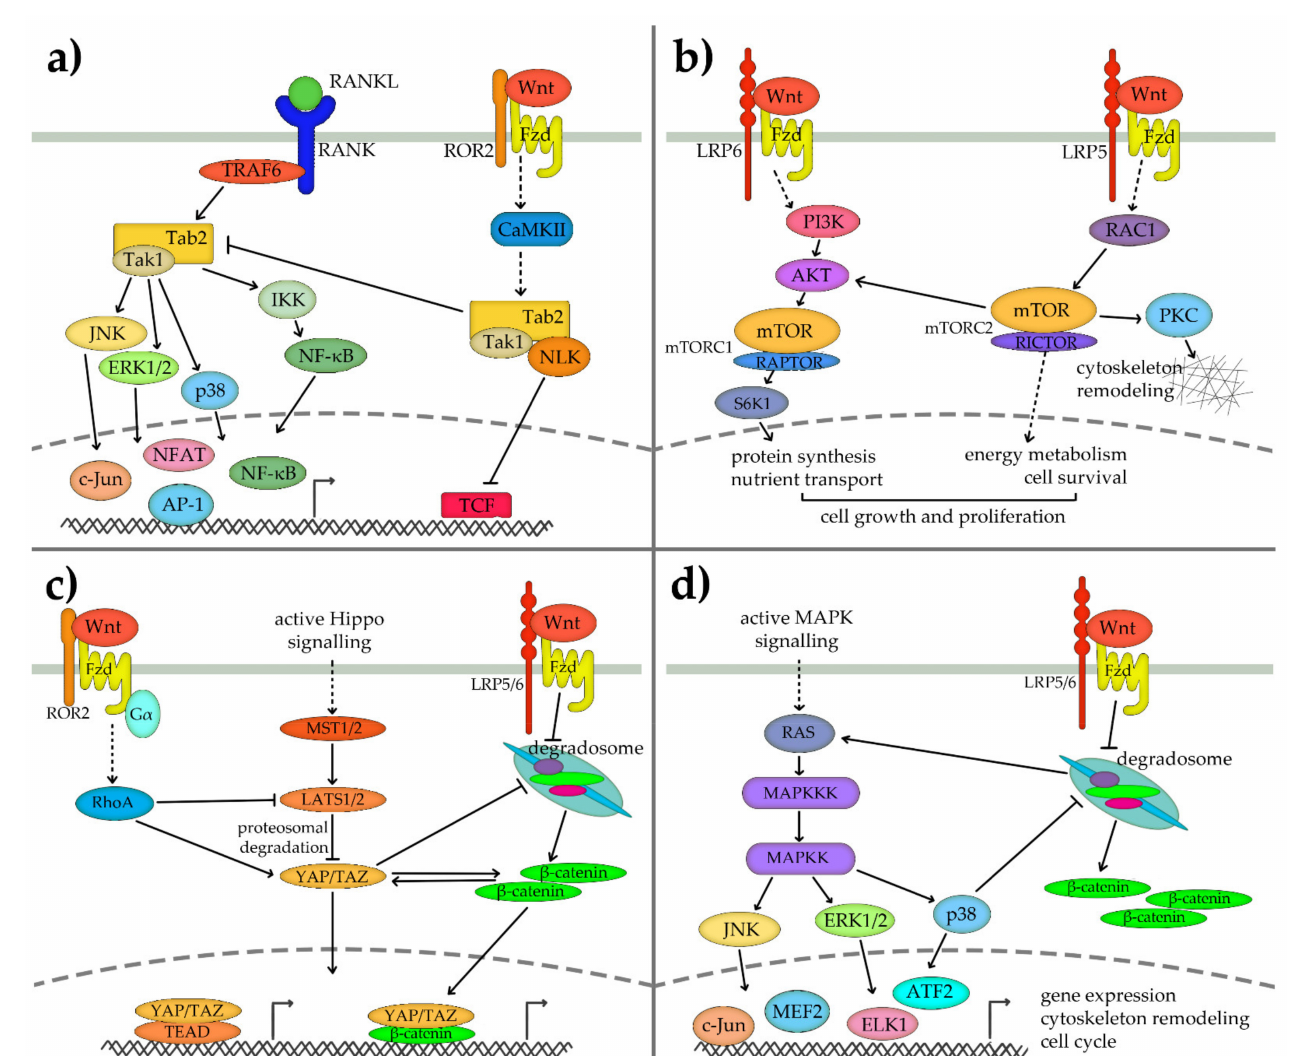
( a ) Non-canonical Wnt signalling inhibits the RANK-RANKL signalling pathway through the inhibition of the formation of the TRAF6-TAB2-TAK1 complex by sequestering TAK1 to the Wnt-induced TAB2-TAK1-NLK complex. This complex activates NLK kinase, which inhibits the TCF/LEF protein family through phosphorylation. ( b ) The non-canonical Wnt signalling pathway interacts with mTOR in osteoblasts through two mechanisms. mTORC1 complex is activated through LRP6/Fzd-PI3K-AKT pathway and results in increased activity of S6 kinase 1 (S6K1) and increased protein synthesis. On the other hand, mTORC2 activation is mediated through Rho-family small GTPase RAC1 and leads to the activation of AKT and other signal transduction pathways, which results in changes in glucose and lipid energy metabolism, cell survival and cytoskeleton reorganisation. Both processes are required for adequate cell growth and proliferation. ( c ) The Hippo signalling pathway is activated through cell–cell attachment and cell adhesion. When active, it activates MST1/2 kinases and LATS1/2 kinases, which inhibit YAP/TAZ activity by inducing its proteosomal degradation. Non-canonical Wnt signalling through ROR2/G α 12/13 G protein/RhoA kinase inhibits YAP/TAZ inhibitor LATS1/2. This releases YAP/TAZ from degradation and enables it to translocate to the nucleus, where it forms complexes with different transcription factors, such as TEAD or β -catenin, to regulate transcription of downstream genes. YAP/TAZ also interacts with the canonical Wnt signalling pathway by blocking the degradosome function and promoting β -catenin cytoplasmic release. ( d ) MAPK signalling pathways involve the activation of small GTPases RAS and a cascade